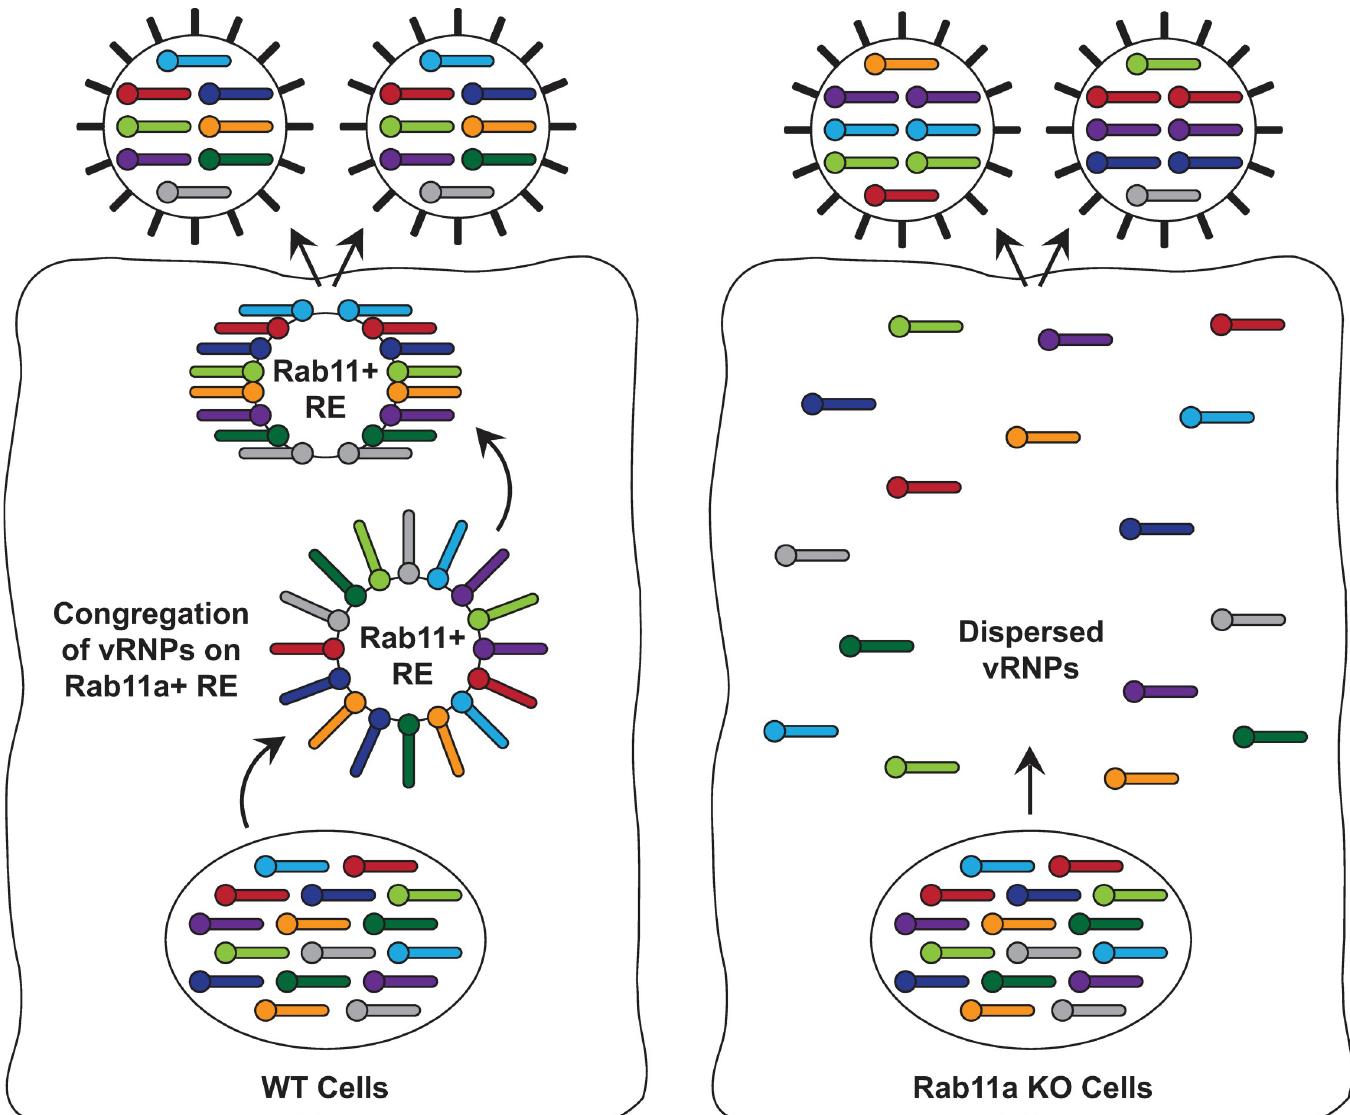
Fig 6. Proposed model for vRNP assembly on Rab11a+ vesicles. vRNPs exported from the nucleus congregate on Rab11a+ recycling endosomes. This increased concentration of vRNPs on Rab11a+ vesicles likely facilitates interactions between individual vRNP segments, promoting selective packaging of the viral genome. In the absence of Rab11a, vRNPs are scattered in the cytoplasm, decreasing the likelihood of association between the eight individual RNP segments, and ultimately resulting in the production of defective particles with misassembled genomes. Individual vRNPs are shown in different colors.